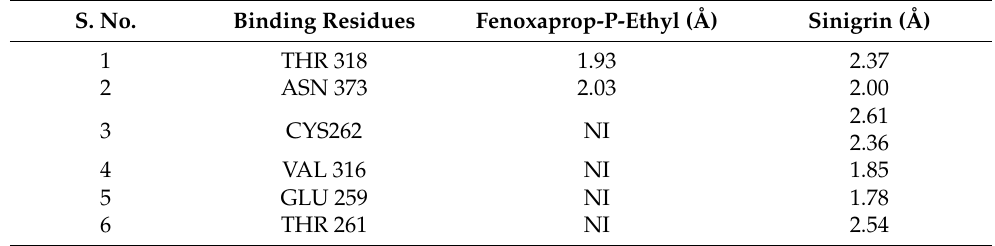
Table 3. The bond length of the amino acids involved in forming hydrogen bond interactions. S.